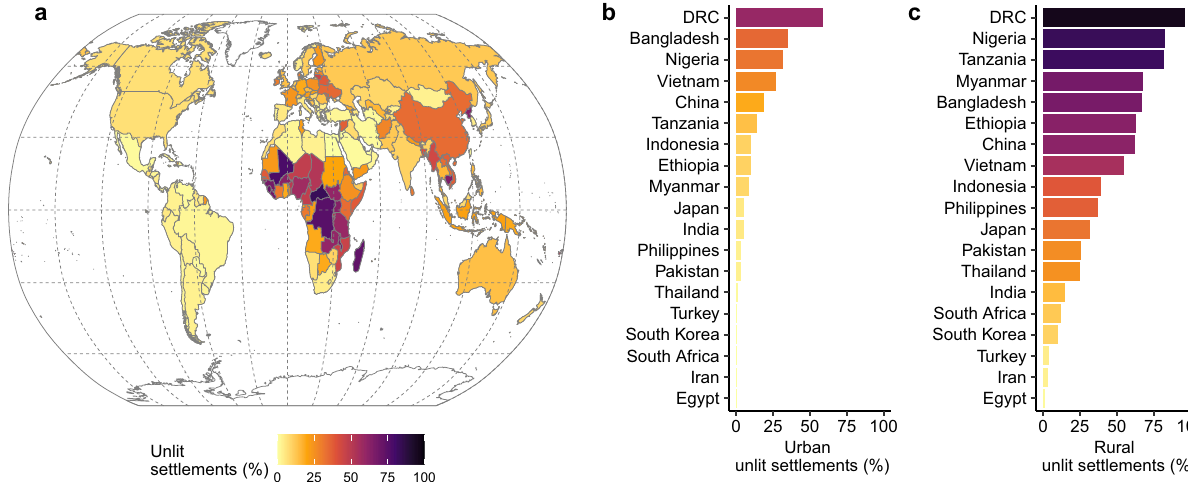
Fig. 1 Global country-level unlit settlement percentages. a map of countries classi fi ed according to their percentage of settlements (building footprints) with no associated satellite-derived nighttime radiance for urban and rural regions combined. b African and Asian countries with population exceeding 50 million ranked according to percentage of urban unlit settlements. c African and Asian countries with population exceeding 50 million ranked according to percentage of rural unlit